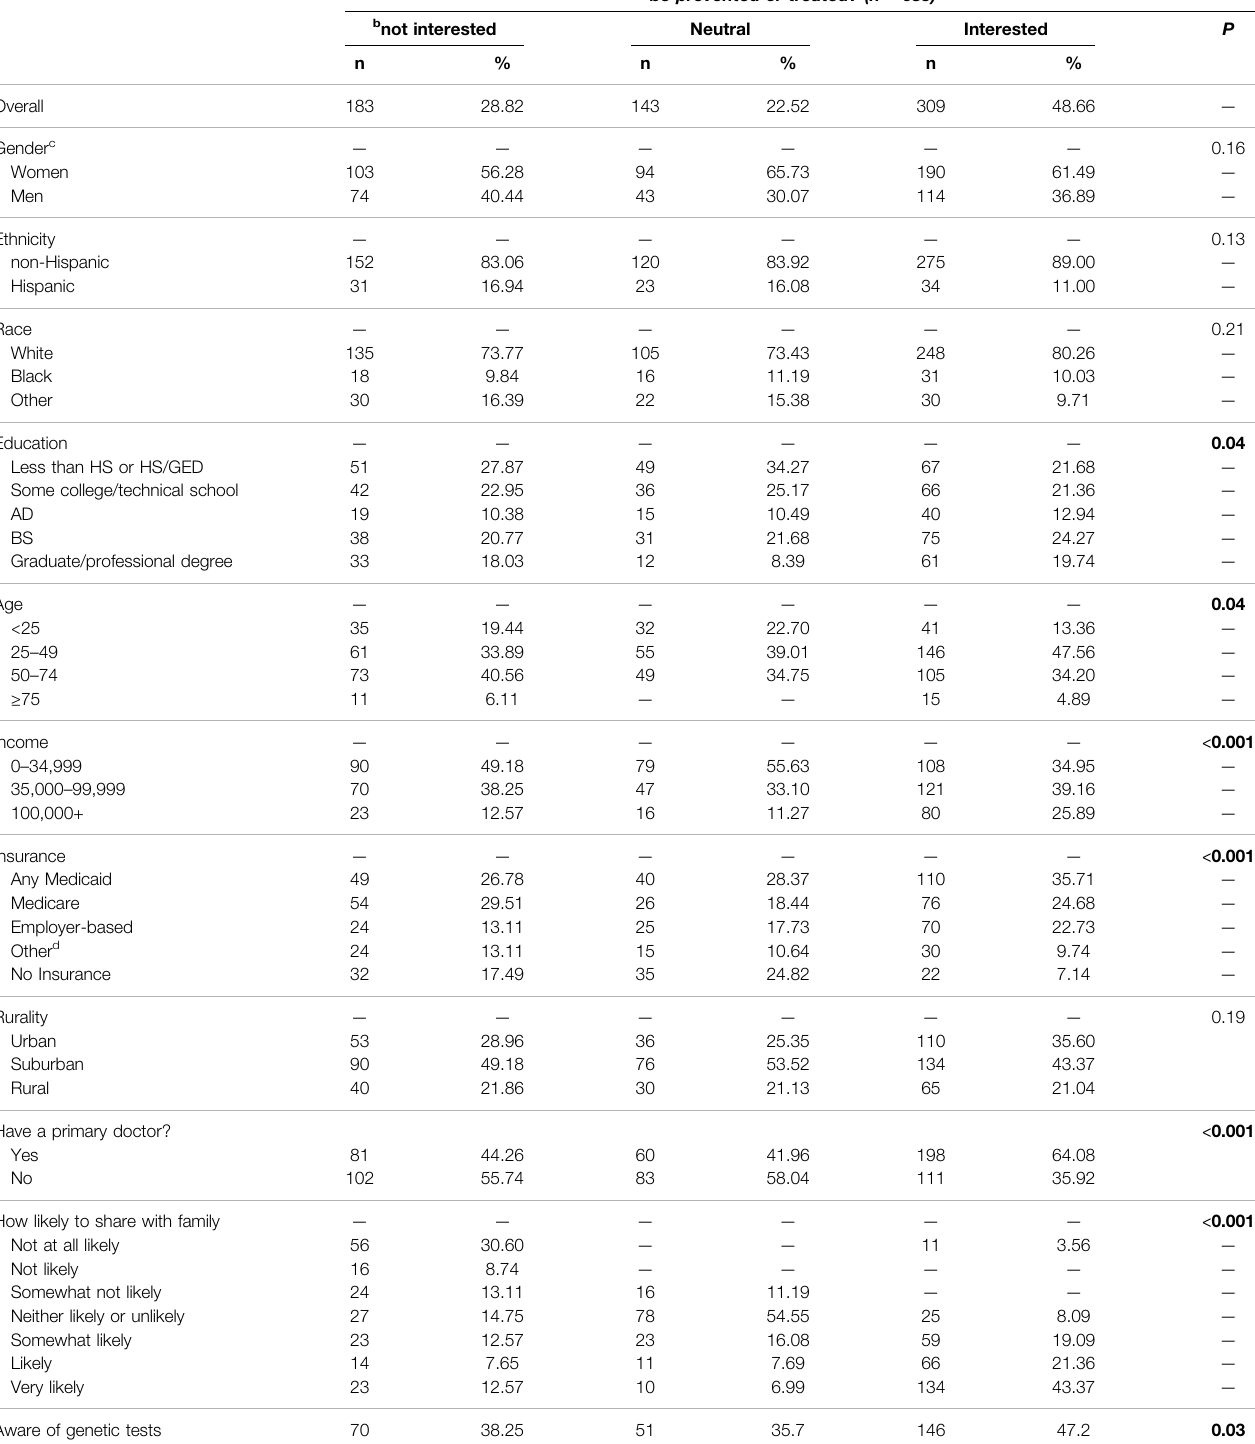
TABLE 3 | Descriptive characteristics among those with different levels of interest in learning about genetic cancer risks.